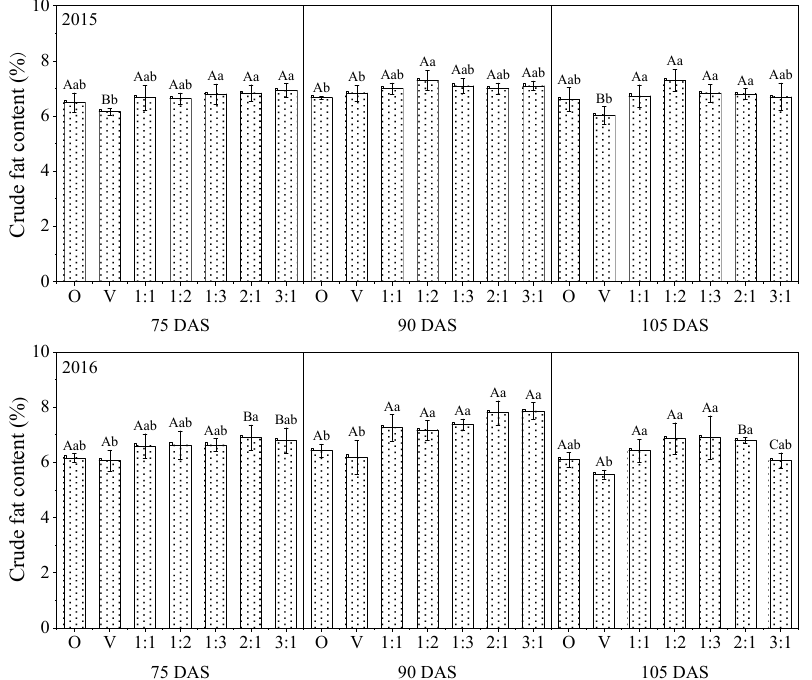
Figure 3. The effect of different intercropping ratio of oat and common vetch on crude fat content of forage.